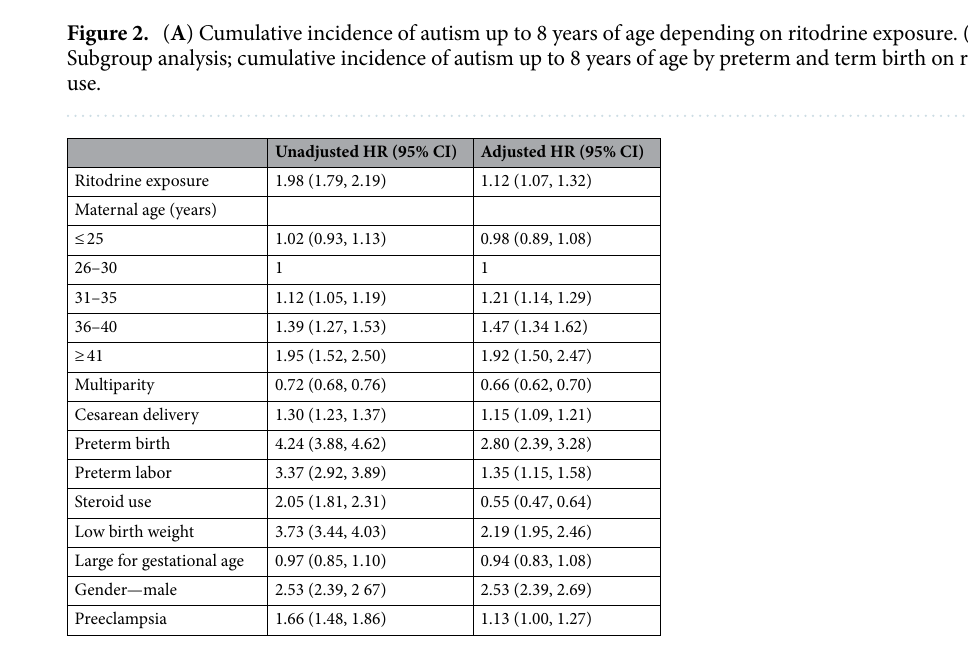
Table 2. Hazard ratios (HRs) of autism according to maternal ritodrine exposure and other risk factors. Hazard ratios were adjusted for variables in table. HR, hazard